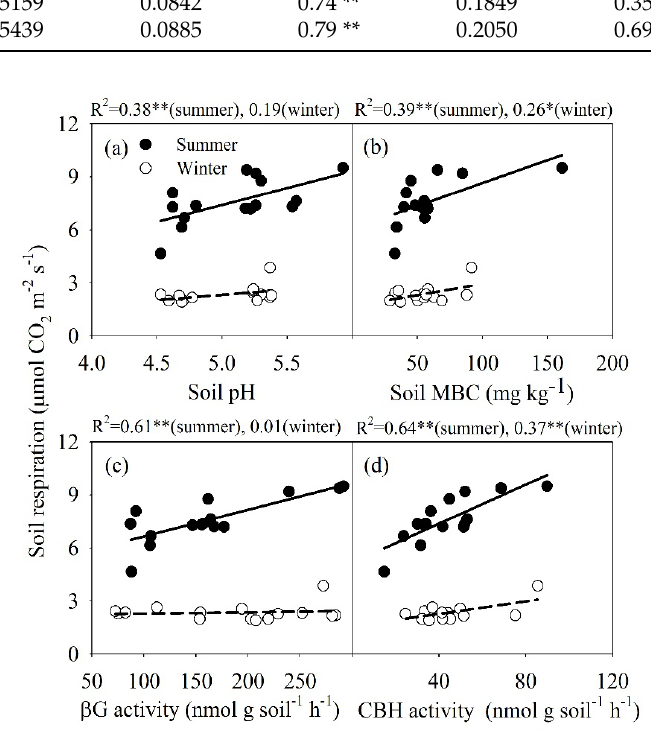
Figure 5. Dependence of soil respiration on soil pH ( a ), soil MBC ( b ), ßG activity ( c ), and CBH activity ( d ) in the summer season (solid line) and winter season (dashed line). * and ** indicates significant difference at p < 0.05 and p < 0.01.